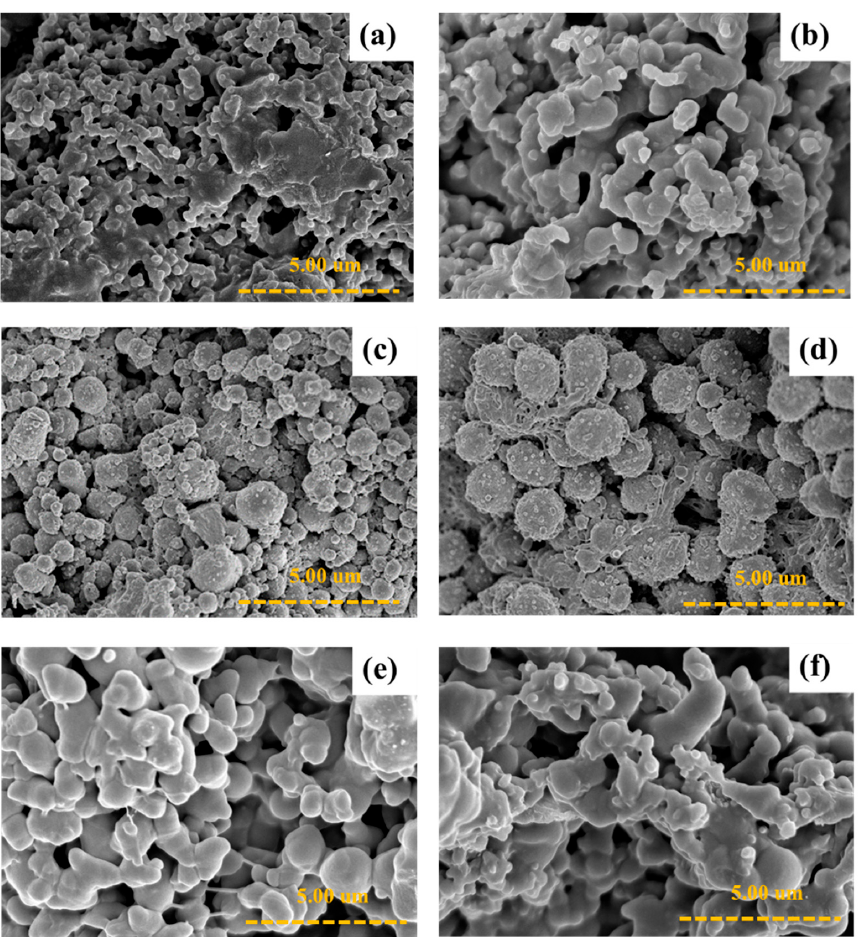
Figure 5. SEM images of P3HT synthesized by chemical oxidative polymerization: ( a ) without DBSA; with various DBSA concentrations ( b ) P3HT_DBSA at 2 CMC; ( c ) P3HT_DBSA at 4 CMC; ( d ) P3HT_DBSA at 6 CMC; ( e ) P3HT_DBSA at 8 CMC; and ( f ) P3HT_DBSA at 10 CMC.